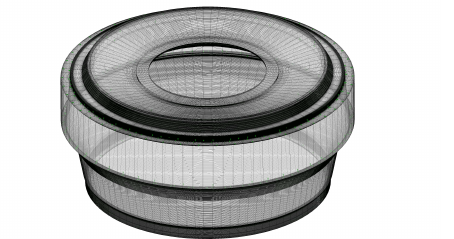
Figure 4. Updated mesh of the 0.5 mm radial installation deviation